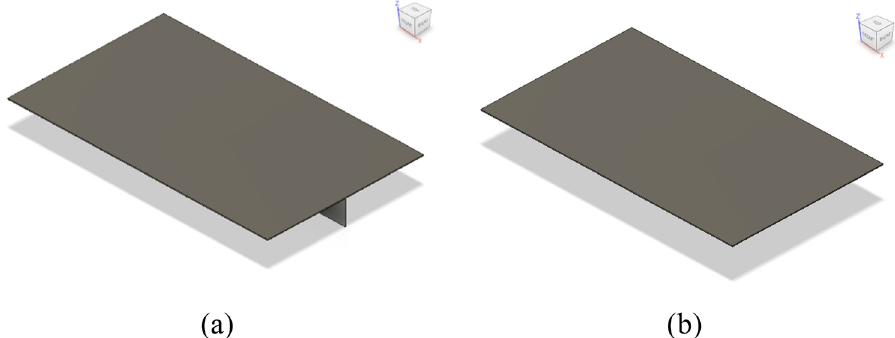
Figure 2: Three - dimensional plate design con fi gurations: ( a ) sti ff ened plate using a FB and ( b ) unsti ff ened